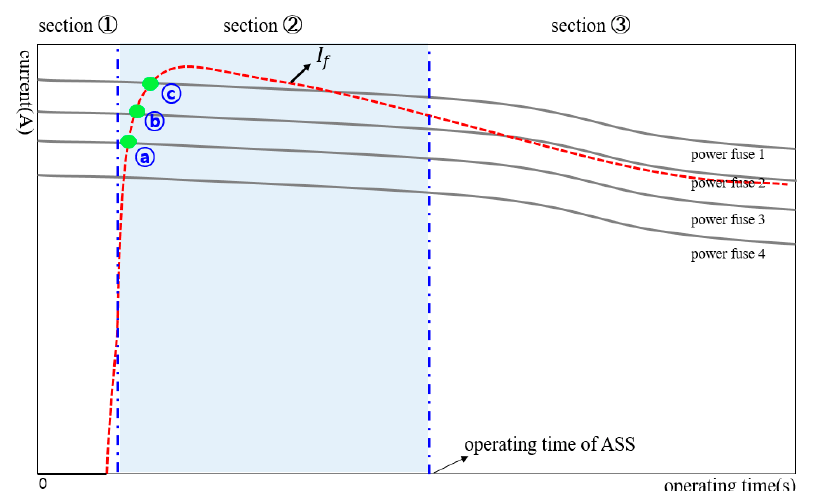
Figure 4. Coordination time between protection devices through Graphic Solution Method.